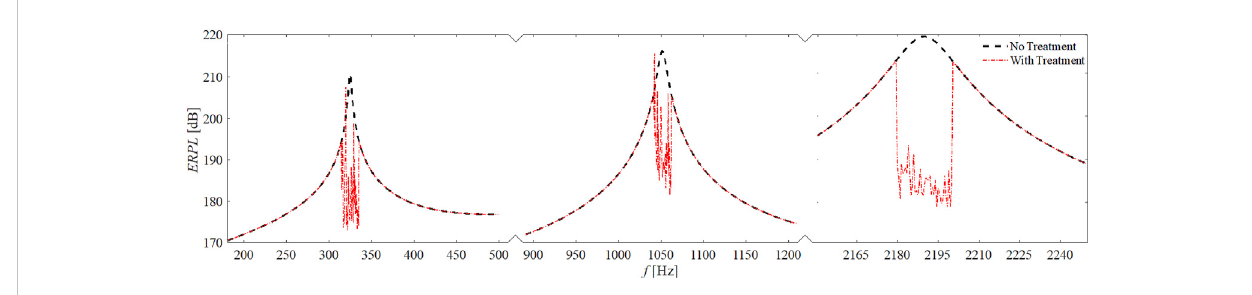
FIGURE 14 ERPL frequency response with and without semi-active treatment.